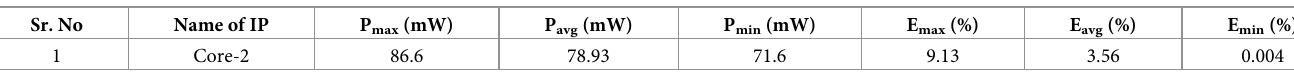
Table 3. Power estimates and accuracy for test-system